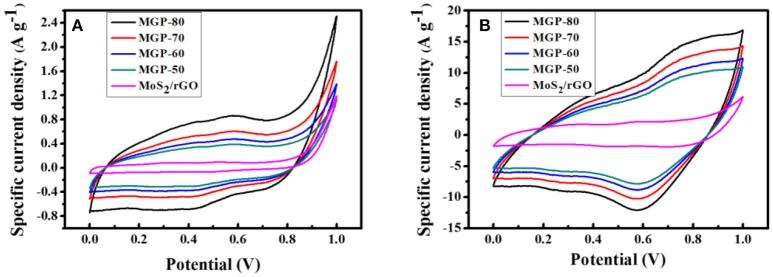
CV curves for the MoS2/rGO binary composite and MoS2/rGO/PANI ternary composites at scan rates of (A) 2 and (B) 50 mV s−1.